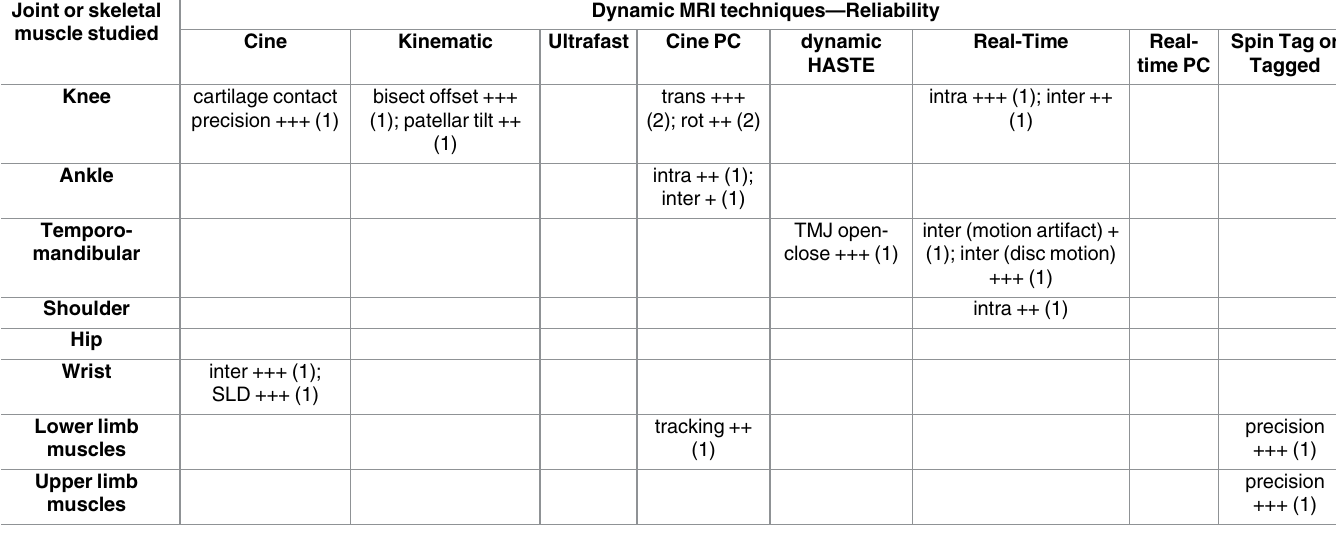
Table 7. Reliability for each joint and muscle studied. Joint or skeletal muscle